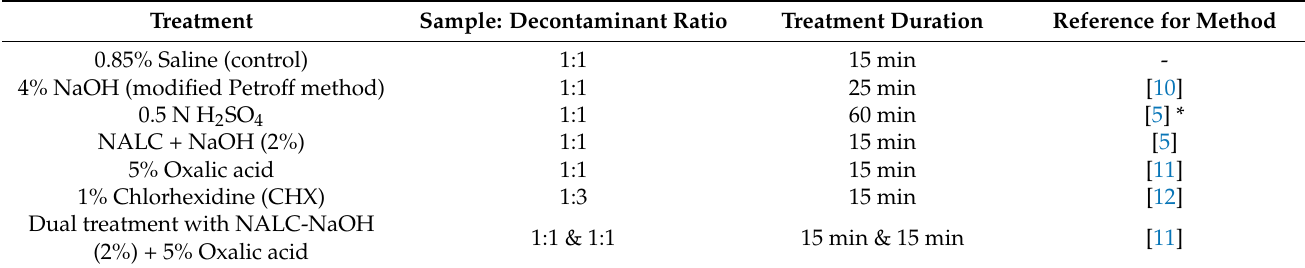
Table 1. Reagents and conditions used for sample